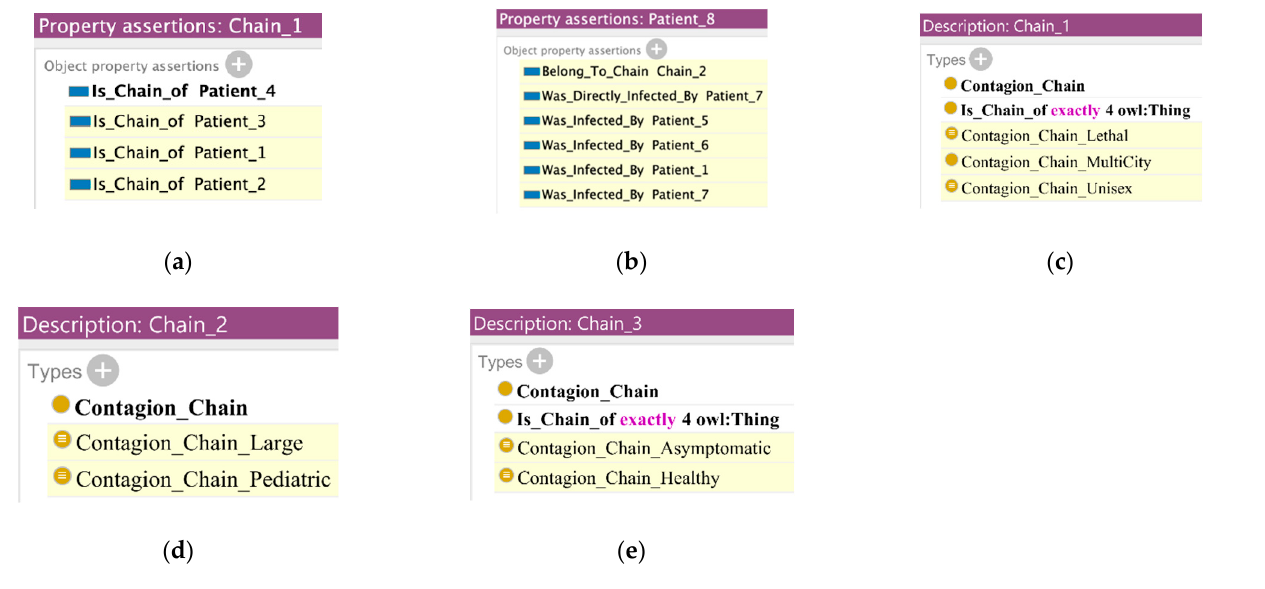
Figure 6. Inferences about the contagion chains: ( a ) Members of Chain_1 ; ( b ) Assertions of Patient_8 ; ( c ) Classifications of Chain_1 ; ( d ) Classifications of Chain_2 ; ( e ) Classifications of Chain_3 .